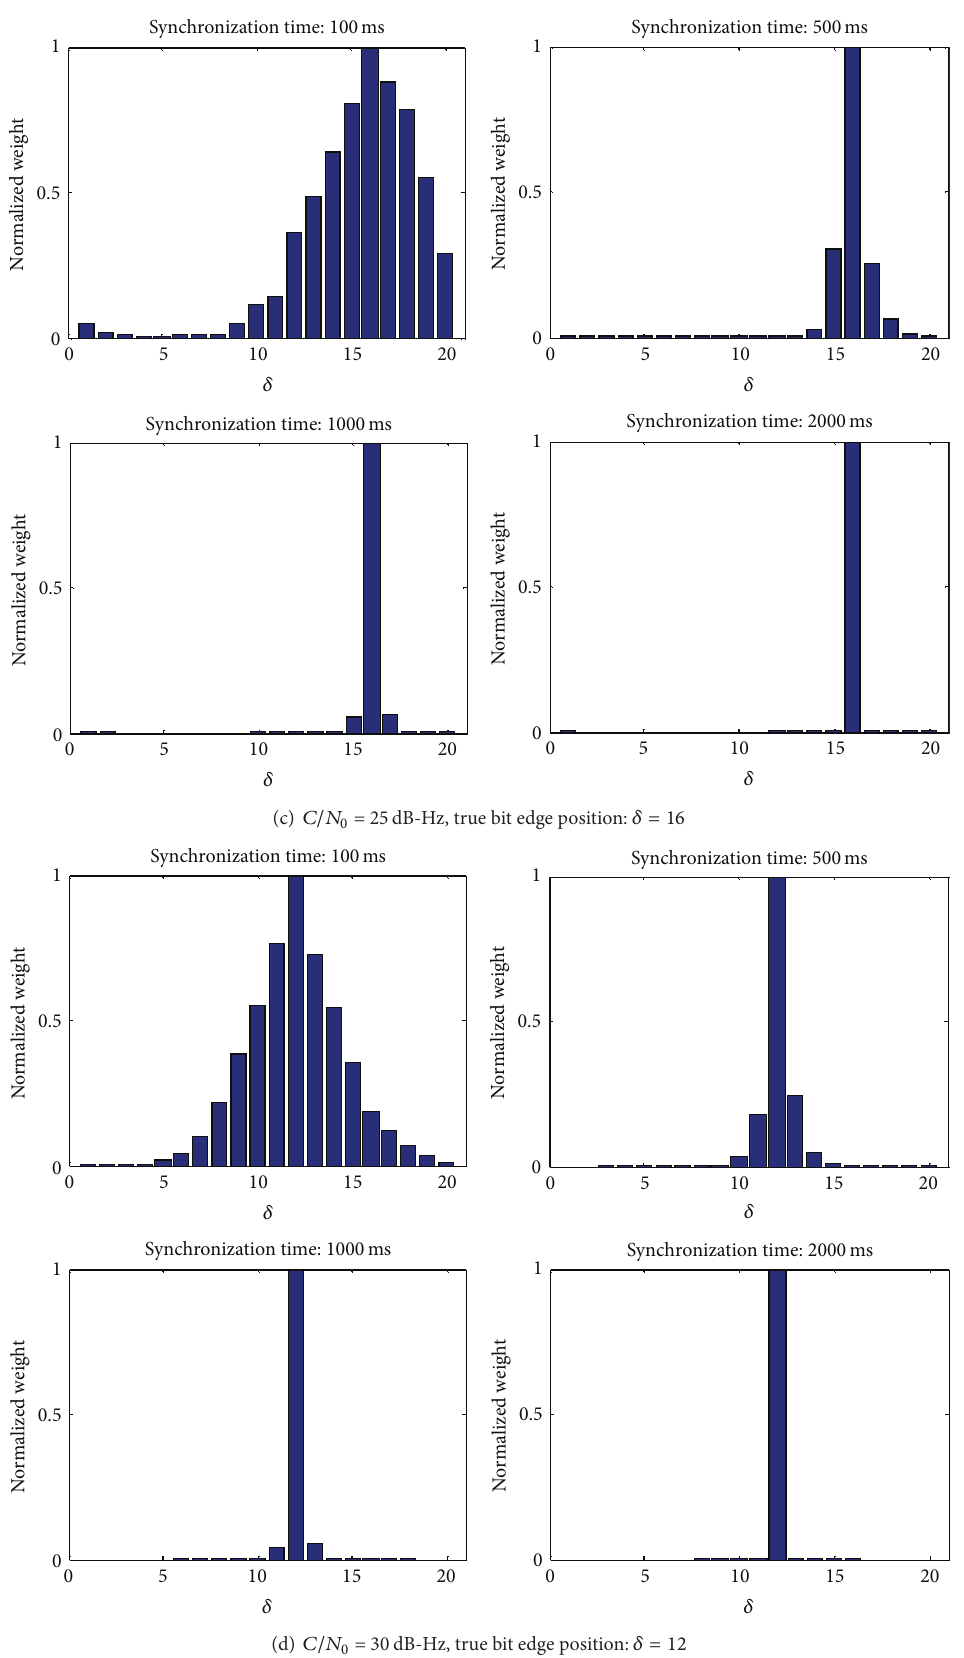
Figure 3: Bit synchronization time